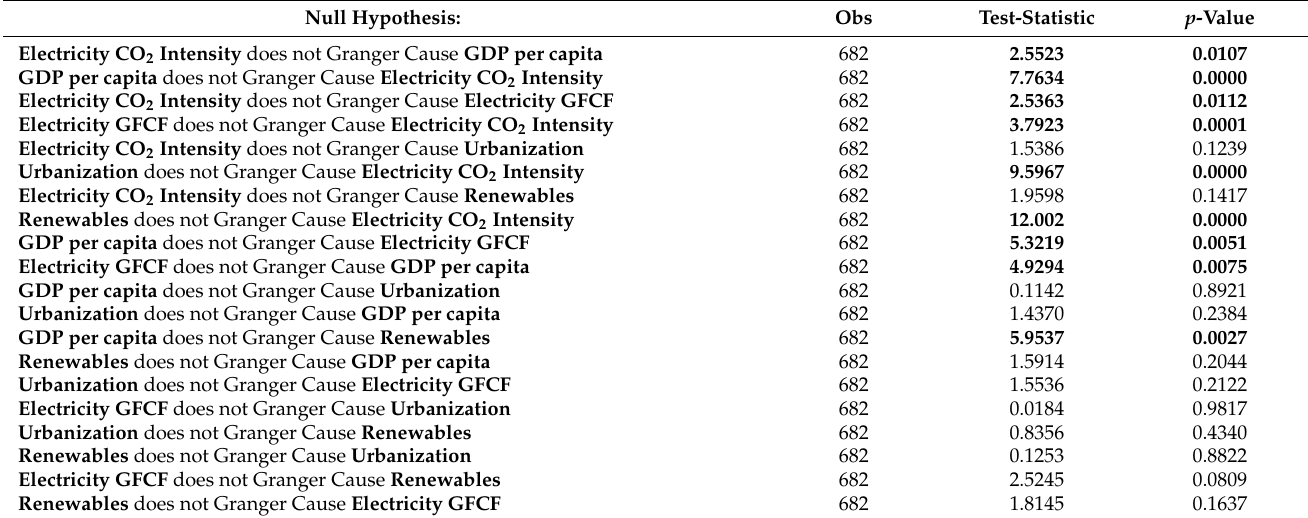
Table 3. Causality testing Lag Order: